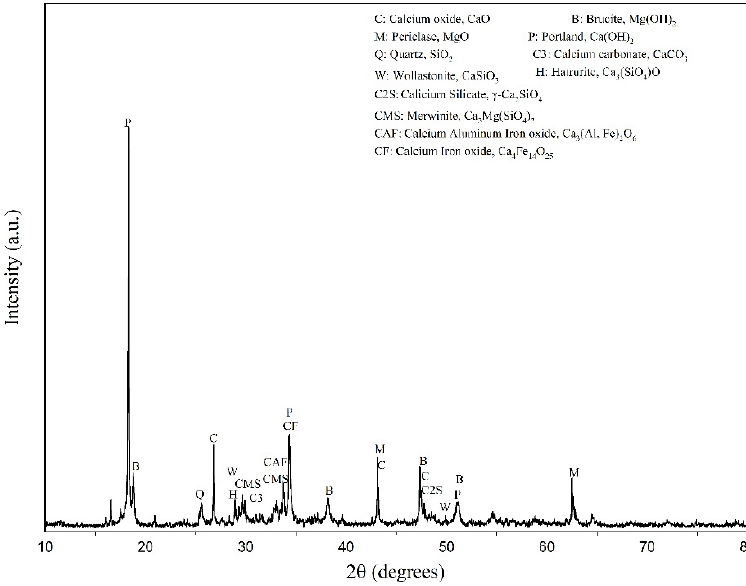
Figure 2. XRD patterns of EAFLS. Table 1. Chemical composition of electric arc furnace ladle slag